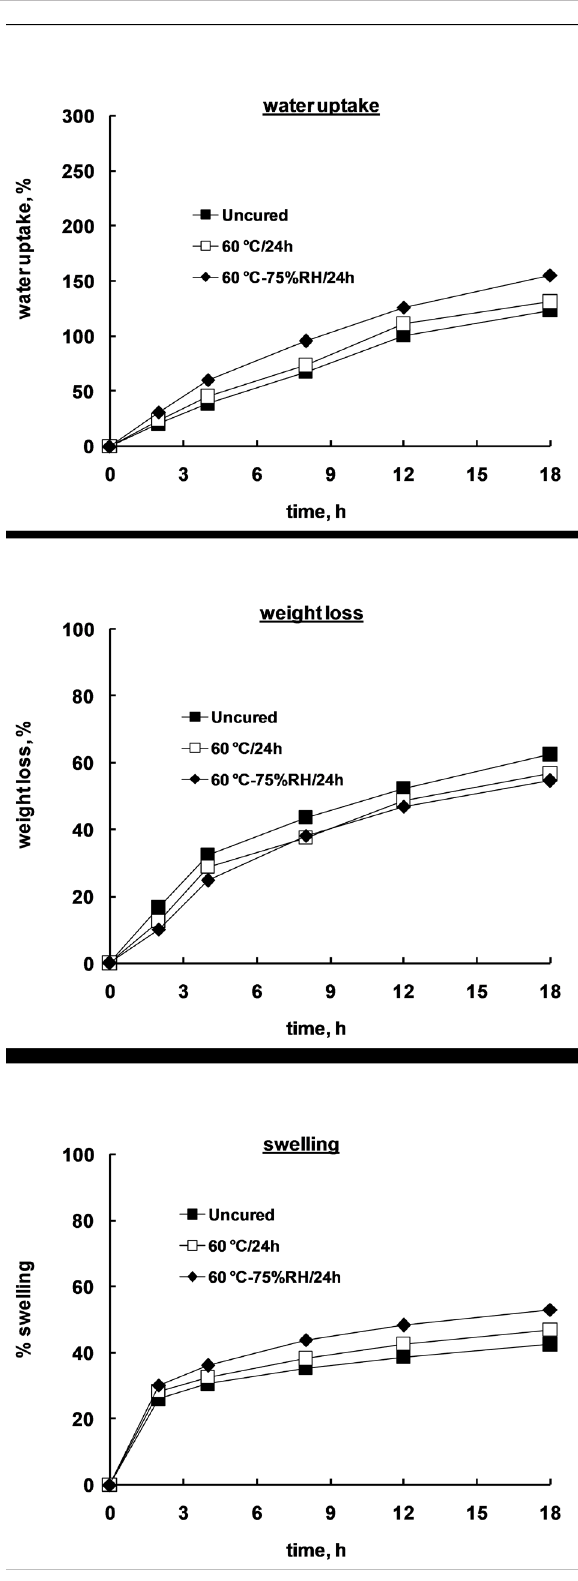
FIGURE 10 - Water uptake-weight loss and swelling of uncured and cured pellets as a function of time in 0.01 N HCl based on sugar cores loaded with 10% propranolol HCl and coated with a polymer blend of Eudragit ® NE 30D: Aquacoat ® ECD (25:75) using 35% talc, coating level